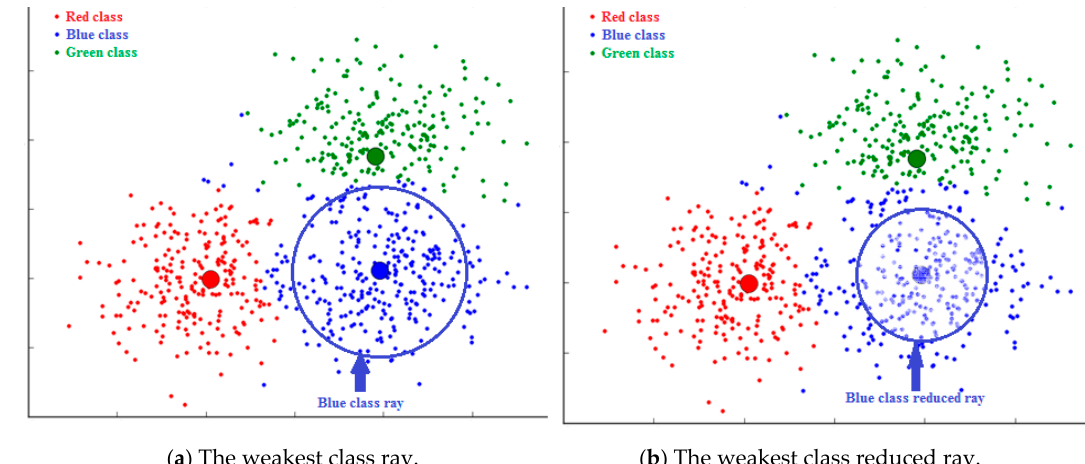
Figure 5. Expand neighborhood structure.